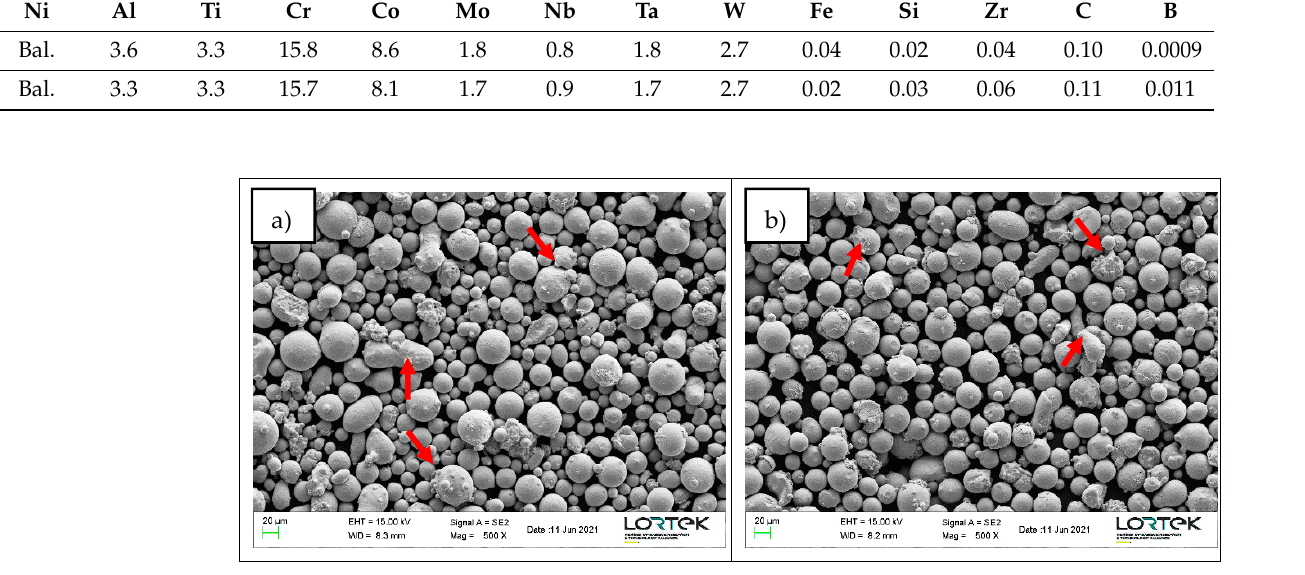
Figure 1. Powder particles SEM images indicating satellites and irregular particles with arrows; ( a ) A&D powder and ( b ) LPW powder. Table 2. PSD for A&D and LPW powders.